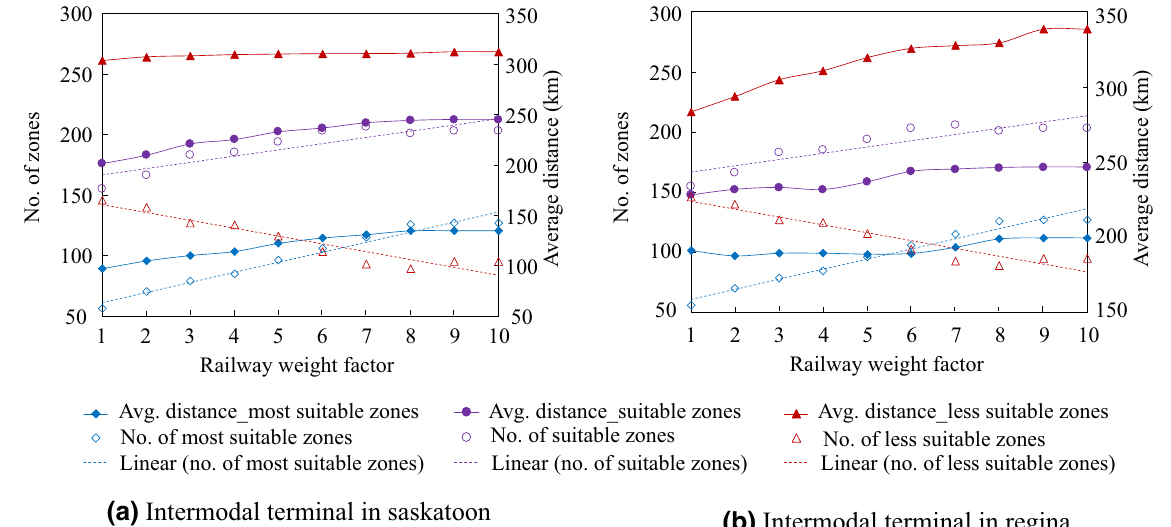
Fig. 16 Variation in quantity and average distance of the most suitable, suitable, and less suitable zones from multimodal terminals considering different railway weight